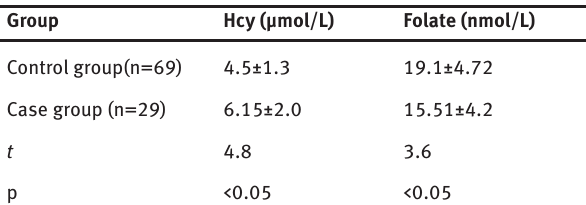
Table 3: Serum Hcy and folate comparison between control and case group ( sx ± ).